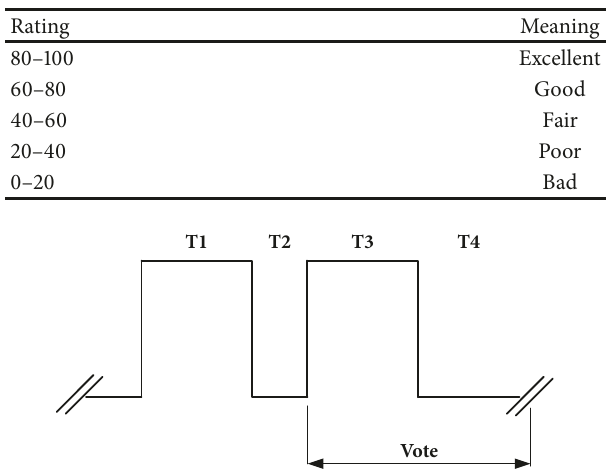
Table 5: DCR 5 level opinion scale. Table 6: Continuous quality scale.